Question: What does this figure show? Answer in one sentence.
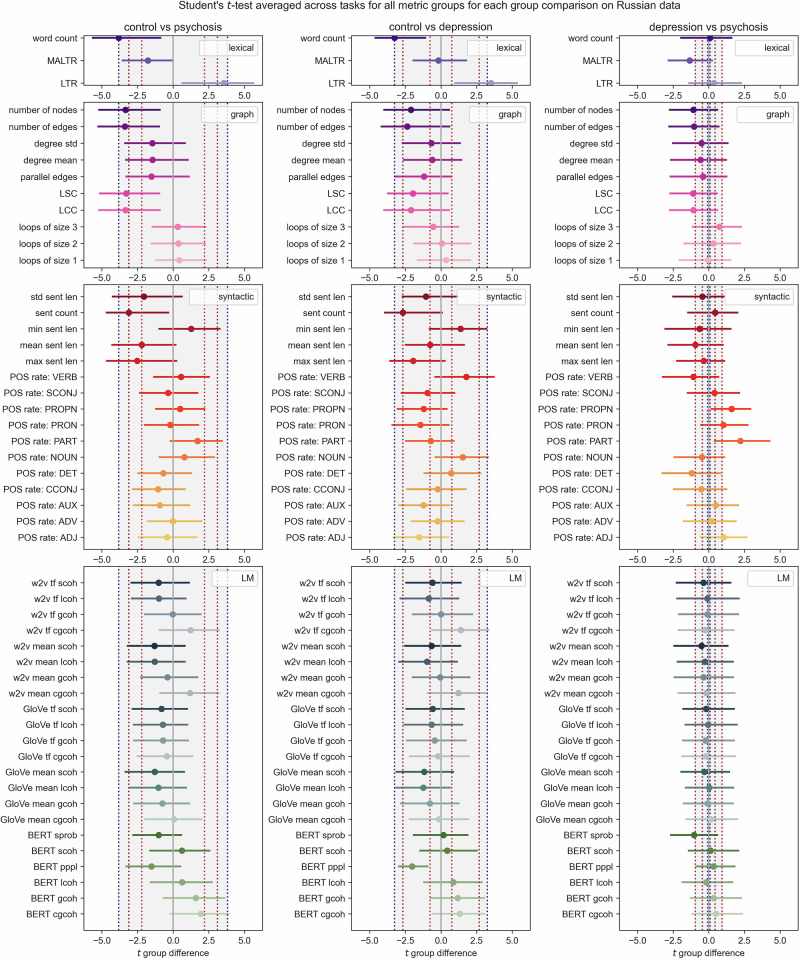
Answer: t-test results on the Russian dataset averaged across tasks for control vs psychosis, control vs depression, and depression vs psychosis comparisons. Each group of metrics is shown as a separate subplot. The word count, mean sentence length, and sentence count baselines are shown with dashed lines, mirrored to represent an absolute value baseline. The gray area indicates a correlation that is weaker than that of the strongest baseline. The intervals around each average indicate 95% confidence intervals obtained with bootstrapping. Each metric is assigned a separate color to facilitate comparison between the two languages.